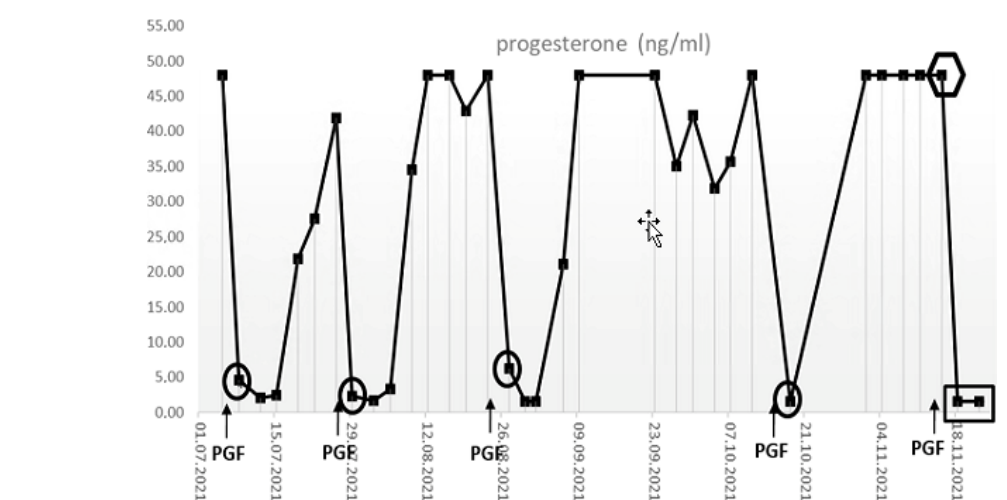
Figure 4. Serum progesterone levels in the animal #17402 after the intramuscular injections of PGF2 α (PGF) during several ovarian cycles. The sample highlighted by the hexagon was taken under alfaxalone anesthesia. Note that this sample was taken 2d after PGF2 α application, which caused the expected marked decline in progesterone concentrations in the previous